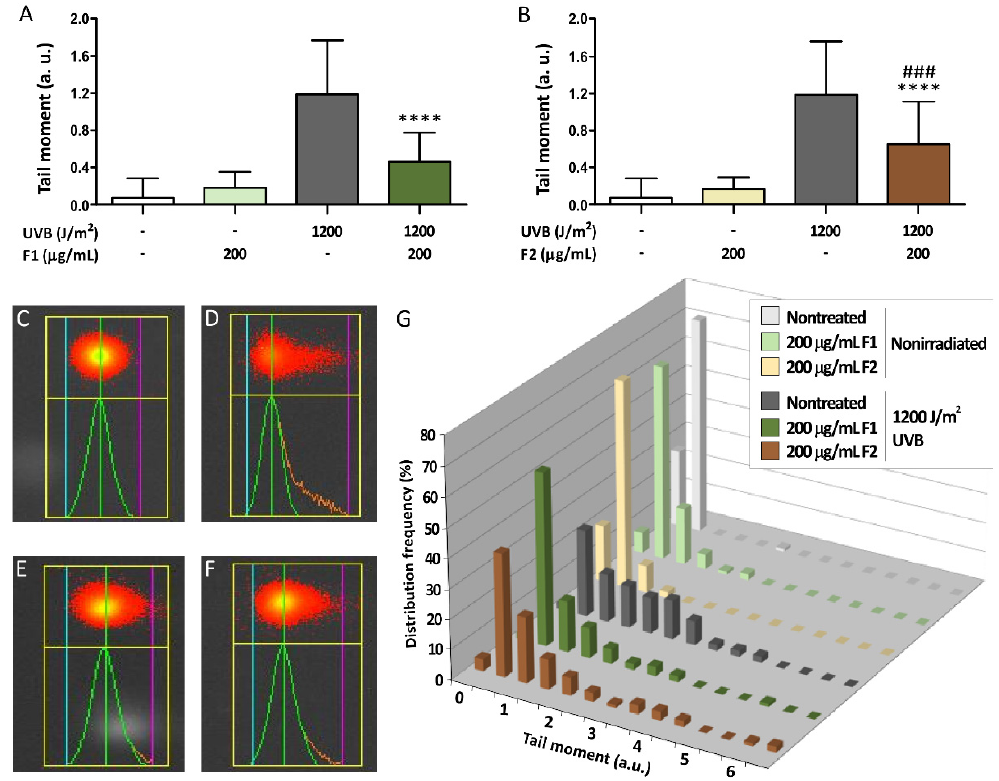
Figure 7. UVB-induced DNA double-strand break formation was inhibited by formulations F1 ( A ) and F2 ( B ) in irradiated human keratinocytes. The tail moment value (the product of the tail length and the tail DNA content) was automatically quantified using Comet Assay IV software. Representative comet pictures of the control of nonirradiated HaCaT cells ( C ), irradiated control cells at 1200 J/m 2 ( D ), irradiated cells at 1200 J/m 2 in the presence of F1 (200 µg/mL) ( E ), and irradiated cells at 1200 J/m 2 in the presence of F2 (200 µg/mL) ( F ) are shown. The blue, green, and magenta lines indicate the start of the head, the center of the head and the end of the tail, respectively. The distribution frequency of tail moment values ( G ) was similar in nonirradiated cell populations and was altered due to UVB-induced DNA damage. The data are expressed as the mean ± SD. **** ( p < 0.0001) indicates significant differences from the irradiated and nontreated controls, while ### ( p < 0.001) indicates significant differences between irradiated cells treated with the other formulation.